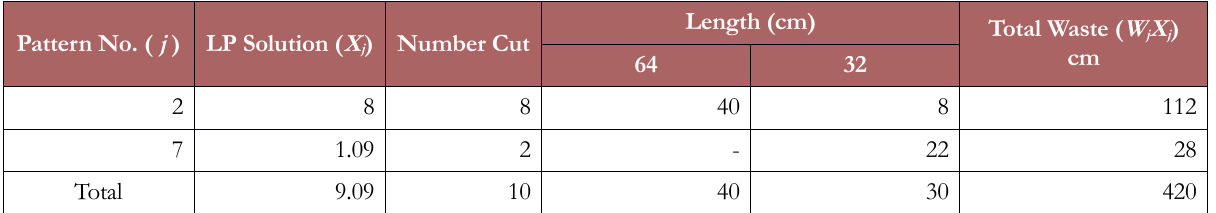
Table 9. Number of 28cm width to be used to produce Product II (Case II)